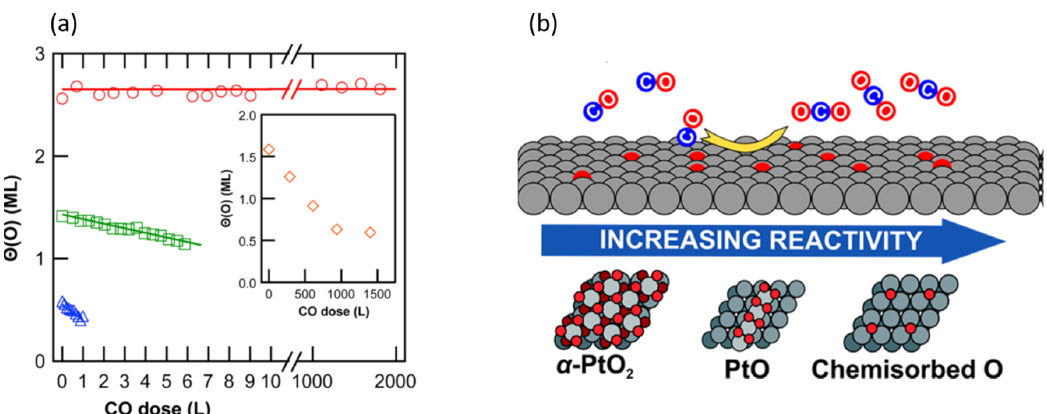
Figure 10. ( a ) Relative reactivity of different coverages of oxygen on Pt(111): red circles = a completely oxidized PtO 2 /Pt(111) surface; green squares, a surface partially covered with a PtO 2 /PtO surface oxides; blue triangles, a surface covered only with chemisorbed O only with no formation of surface oxide. ( b ) a schematic representation of the derived relative reactivity of the chemisorbed O, and PtO and PtO 2 surface oxides as derived from time resolved XPS. The complete (ca. 2.8 mL) α -PtO 2 structure corresponds to the does above ca. 1000 L as indicated in the inset to Figure 10. Both the chemisorbed O and PtO structure can be formed at lower coverages alongside domains of the α -PtO 2 surface oxide at lower doses and their relative reactivities assessed in a single shot using XPS. See [135]. Reproduced